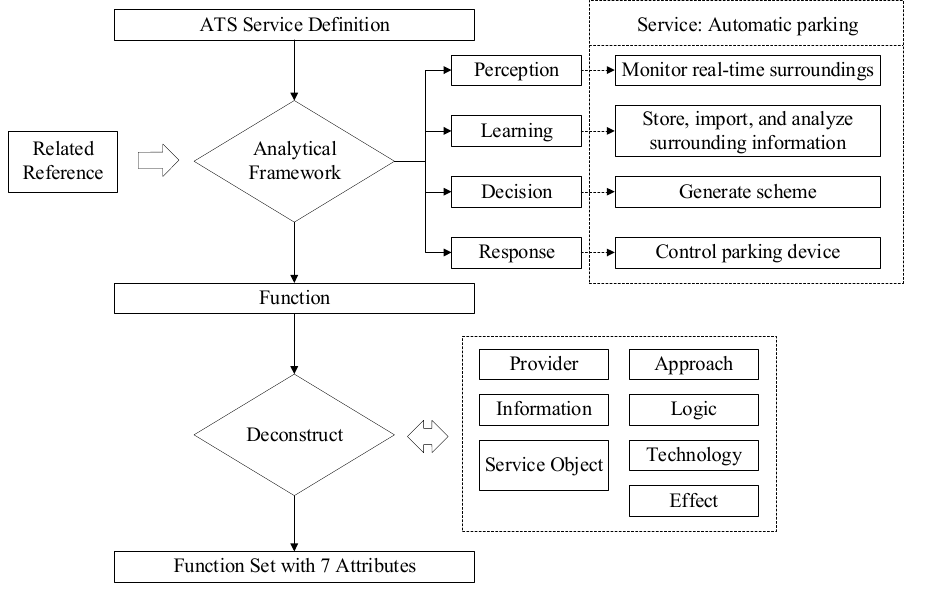
Figure 3. Flow diagram of data collection and process. Table 1. Examples of function text